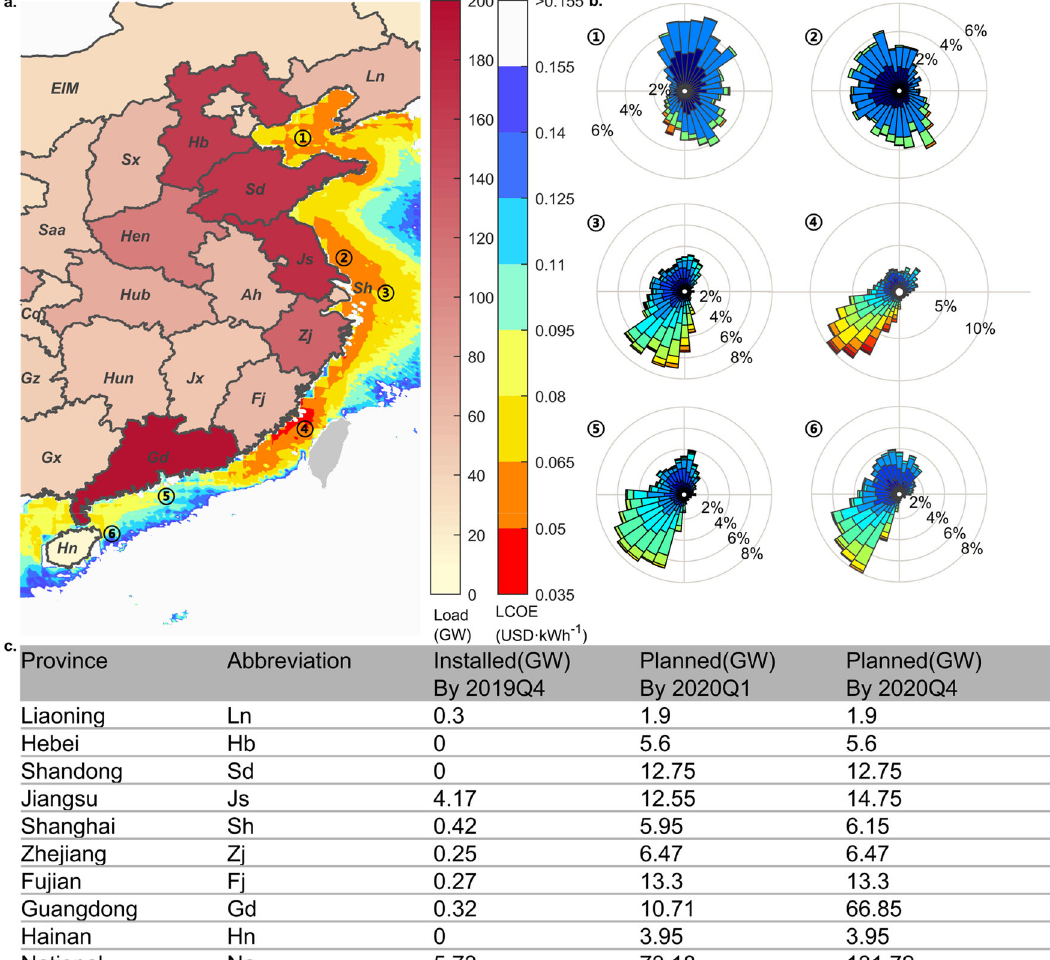
Fig. 1 | Levelized cost, wind directions and development plan ofOffshore wind powerinmainlandChina.a provincialpeakloadandoffshorewindlevelizedcosts for mainland China; b wind roses at typical locations for offshore wind